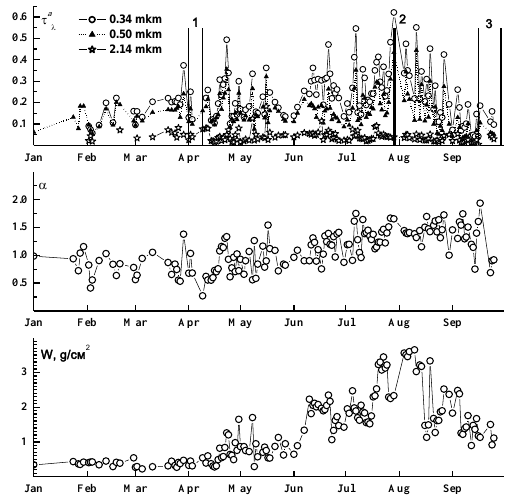
Figure 10. Time variations in the spectral AOD, Ångström expo- nent α , and water vapor total content W in Tomsk during 2013 (lines 1, 2, and 3 show the measurement cycles within the